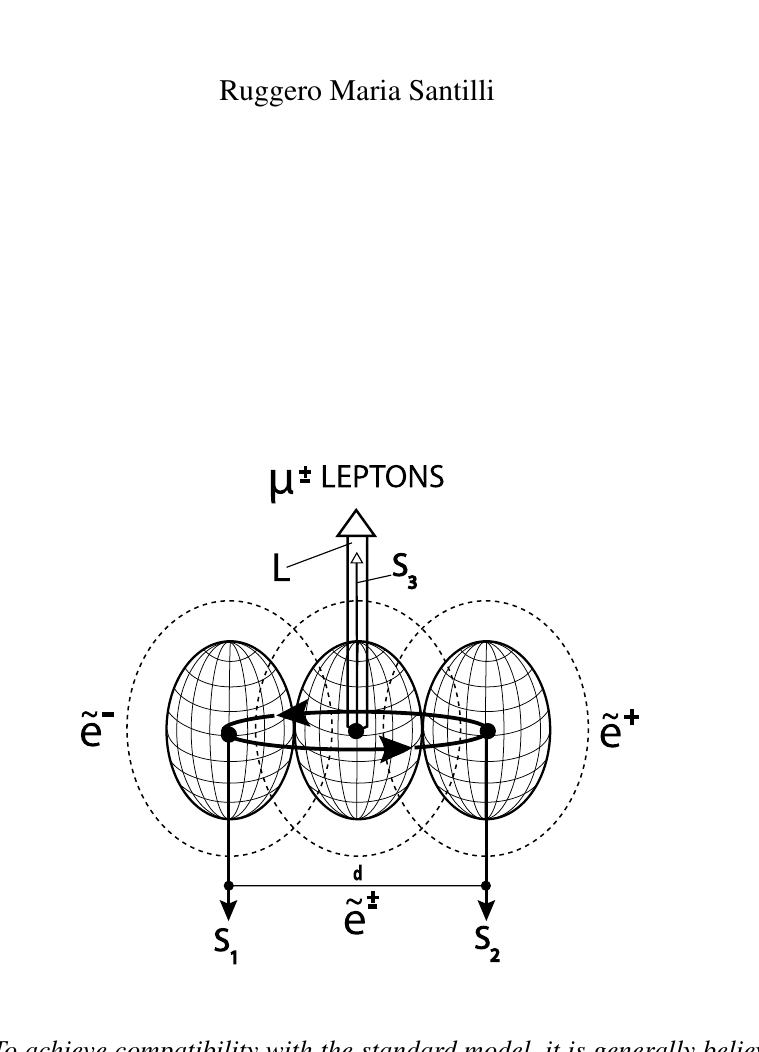
Figure 7: To achieve compatibility with the standard model, it is generally believed that muons are elementary particles in contrast with the experimental evidence that they are naturally unstable with various decay modes (51) that strongly suggest a composite struc- ture. In this figure, we present a conceptual rendering of the structure of the µ ± leptons predicted by hadronic mechanics as a three-body of elementary isoconstituents identified in the muon decay with the lowest mode. The weak interaction character of the parti- cles is derived from a weak hadronic bound state essentially given by the overlapping of the classical radius of the constituents indicated by dashed ellipses. By recalling that all three constituents have a point-like charge, the dimension d of the charge radius of the two peripheral constituents is purely